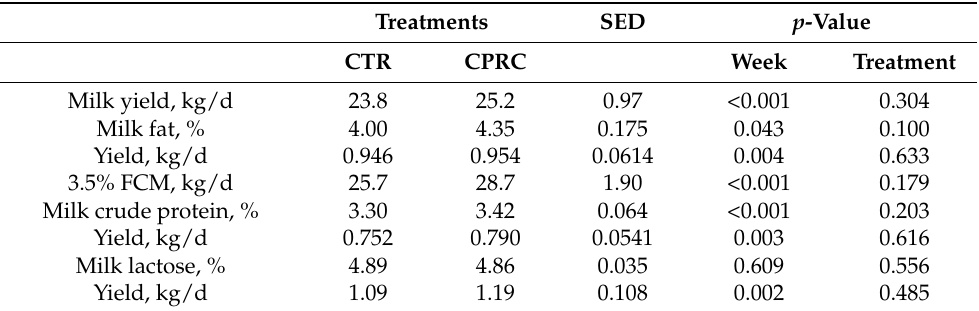
Table 9. Effect of feeding cold-pressed rapeseed cake on milk yield and composition of lactating dairy cows (LSM, n = 18). Treatments SED p -Value CTR CPRC Week Treatment Milk yield, kg/d